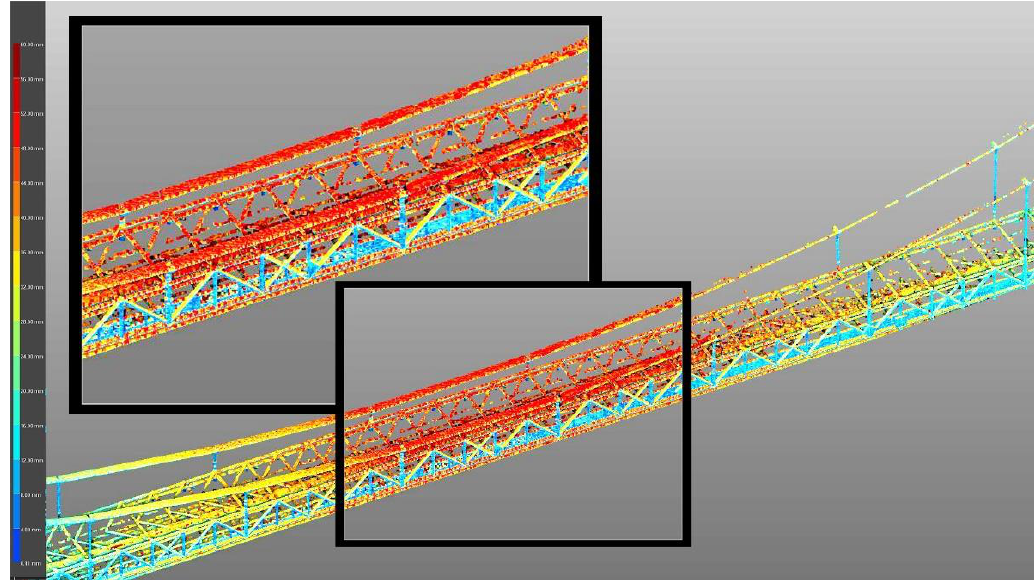
Figure 11. View of bridge deflection details (in colors) using a Trimble TX8 scanner.